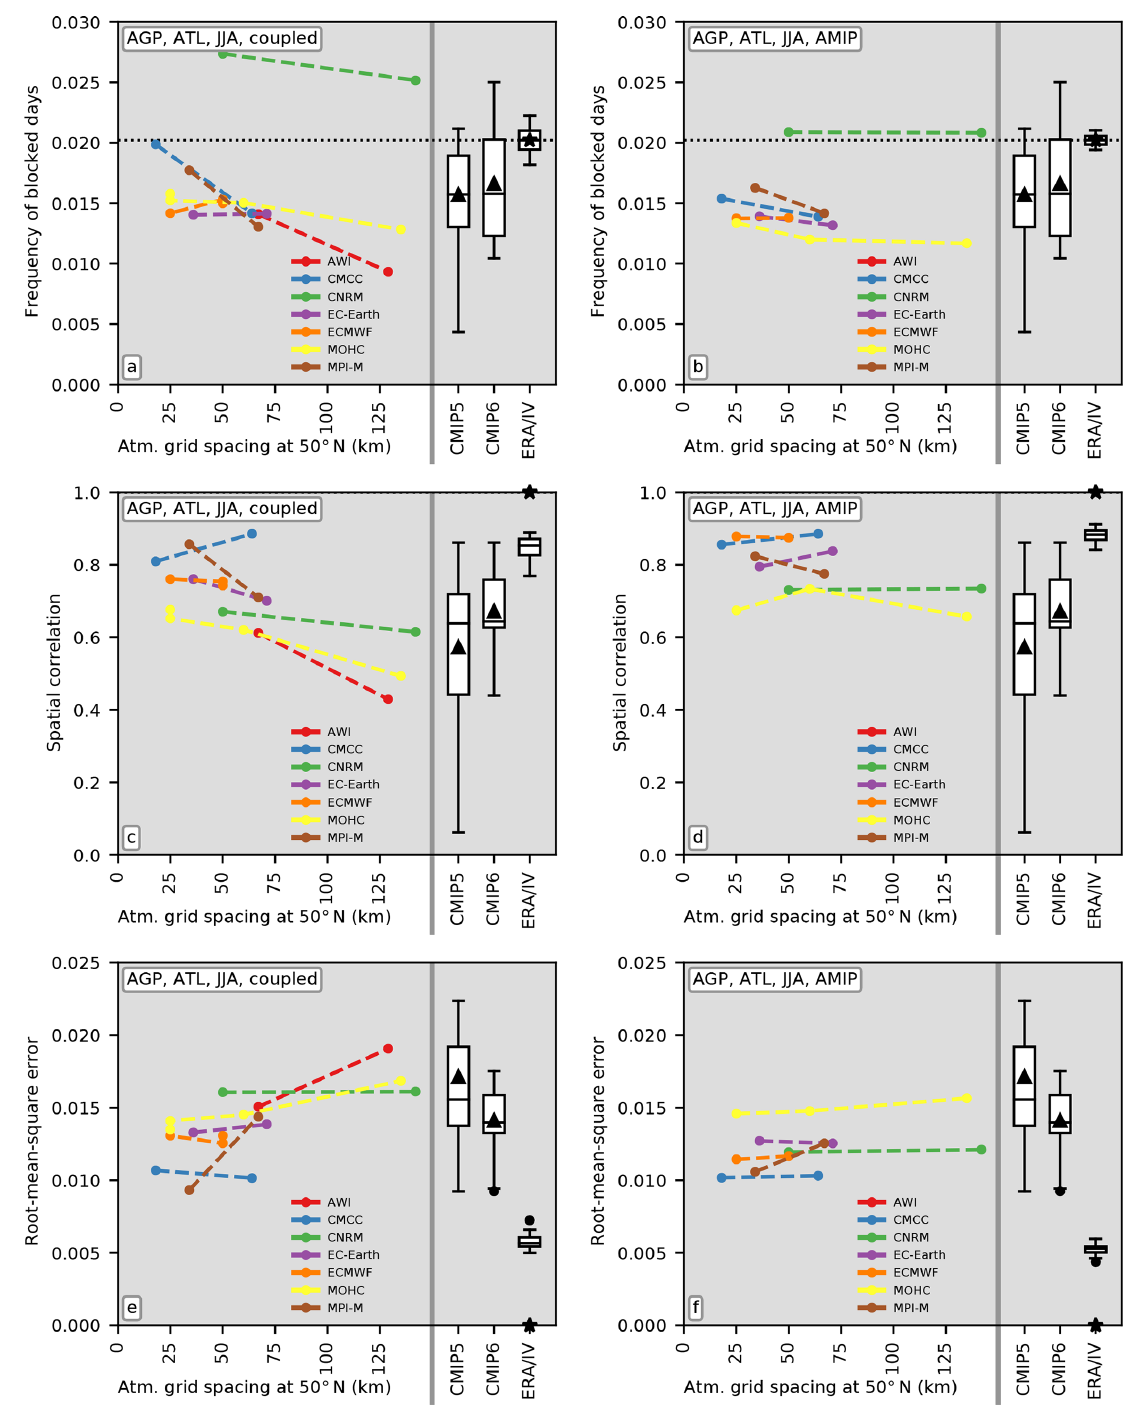
Figure 4. As Fig. 3 but for boreal summer. Metrics of blocking performance ( a, b – blocking frequency, c, d – spatial correlation, e, f – root-mean-square error) for the AGP index and for the ATL domain (50–75 ◦ N, − 90–90 ◦ E). The left-hand side of each panel shows metrics for PRIMAVERA simulations at different grid spacings (resolutions). Boxplots on the right-hand side show distributions of the metric across CMIP5 and CMIP6 simulations. The “ ∗ ” symbol in the column “ERA/IV” shows the reanalysis estimate, and the boxplot is an estimate of the expected agreement given internal variability (see